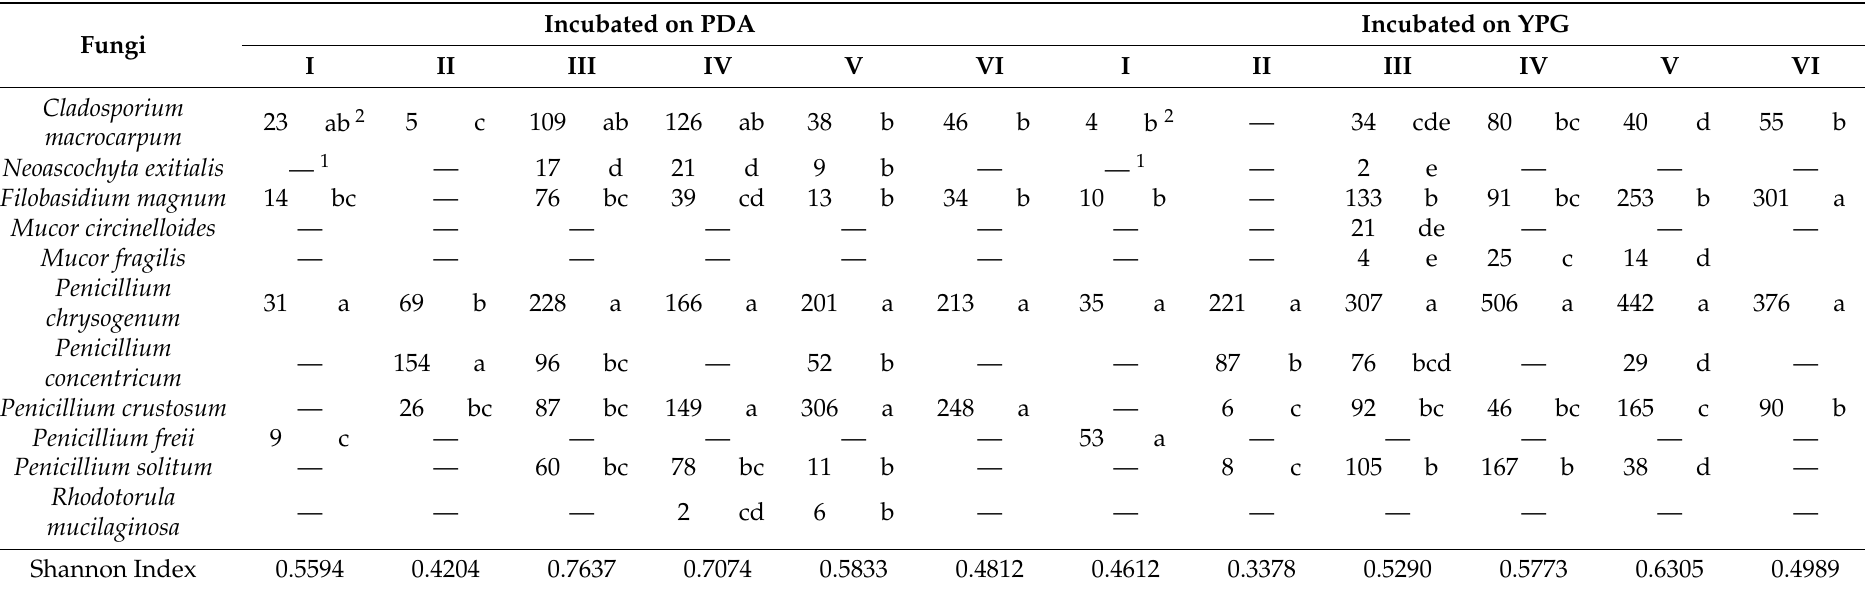
Table A2. The number (CFU m − 3 of air, n = 6) and species composition of airborne fungi cultured at 7 ± 0.5 ◦ C during research in the underground hibernation sites in the Nietoperek bat reserve (study site numbers from I to III) and/or present close (study site numbers from IV to VI) to hibernating Myotis myotis . Study site number I was outside the underground object and locations from II to VI inside it. An air sampler was positioned 1.5 m above the level of the floor in study site numbers from I to III, and it was positioned at a distance of 0.7–1 m from clusters of M. myotis in locations from IV to VI: 1 ”—” means not detected. 2 Statistical analysis was performed only for fungal species that were detected in a given study site. For each location, the number of fungal spores followed by the same letter are not statistically different, and others are (Tukey’s HSD test, α ≤ 0.05). Letters indicate the differences between fungal species in a given location; they refer to means in the columns. All analyses were carried out separately for PDA and YPG.